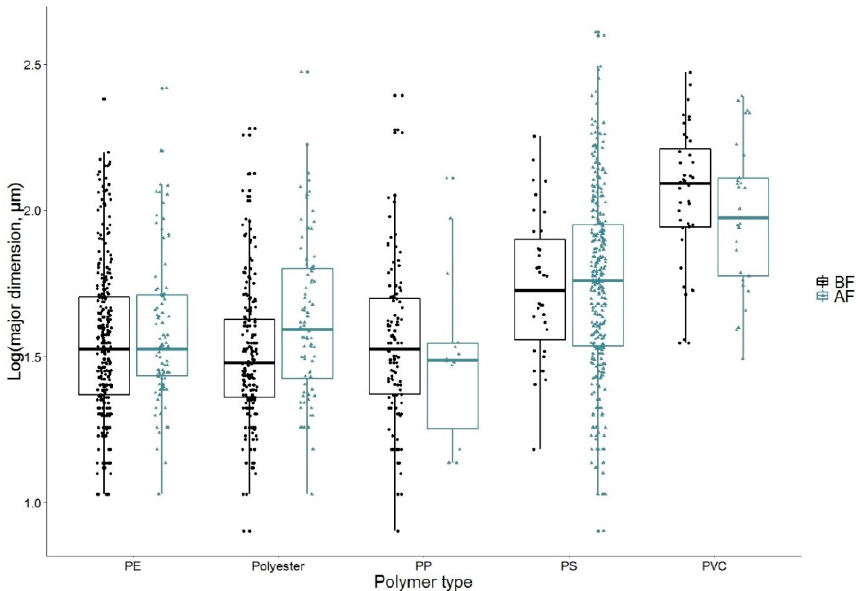
Figure 4. Boxplots of the logarithm of the major dimension of the MPs of the largest polymer groups in the wastewater sample before and after the disc filter. BF denotes the sample taken before disc filter treatment, while AF indicates the post-treatment sample.